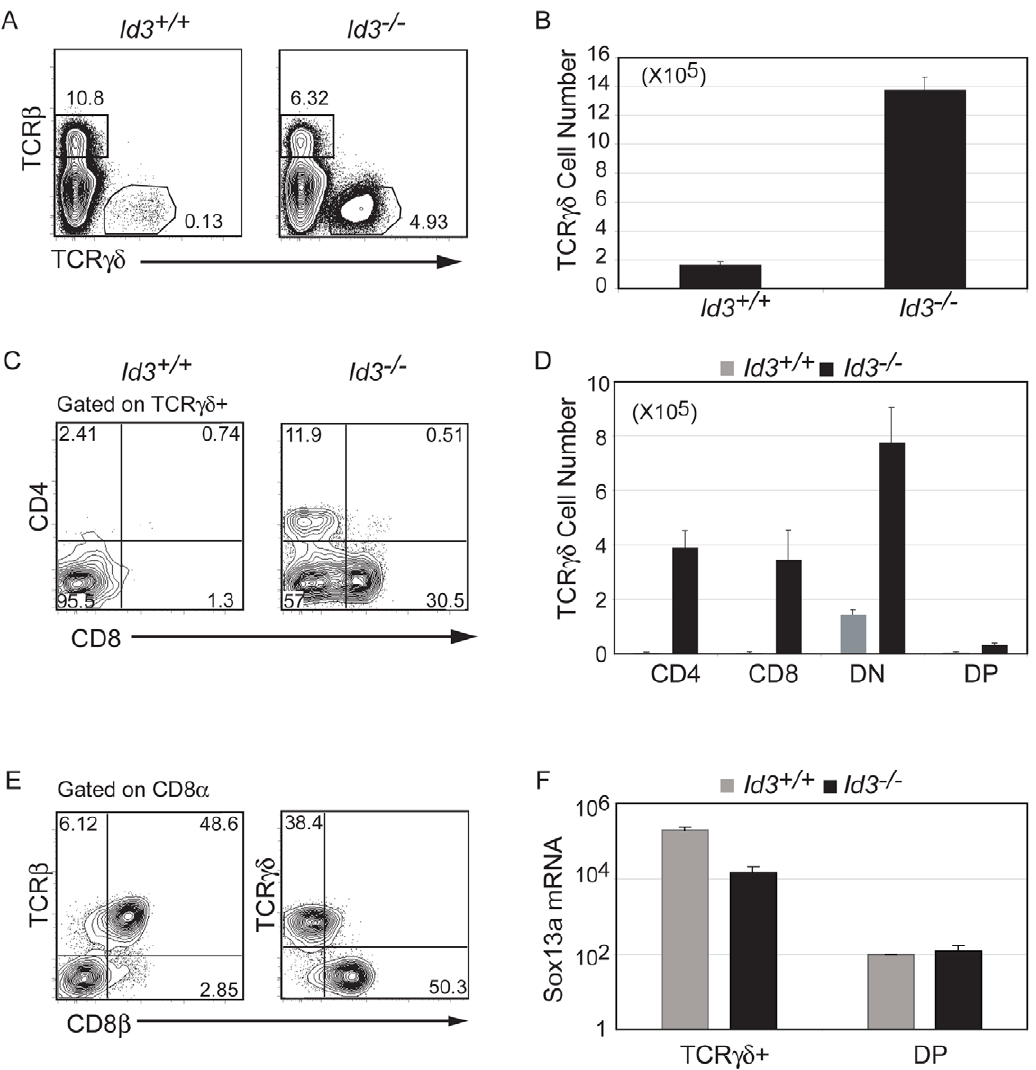
Figure 1. Altered cd T cell development in Id3 2 / 2 mice. A) FACS analysis for TCR b and TCR cd on Id3 + / + and Id3 2 / 2 thymocytes. The frequency of TCR b + cells and TCR cd + cells is shown. B) Number of TCR cd + cells in the thymus of Id3 + / + and Id3 2 / 2 mice. Average + / 2 standard deviation